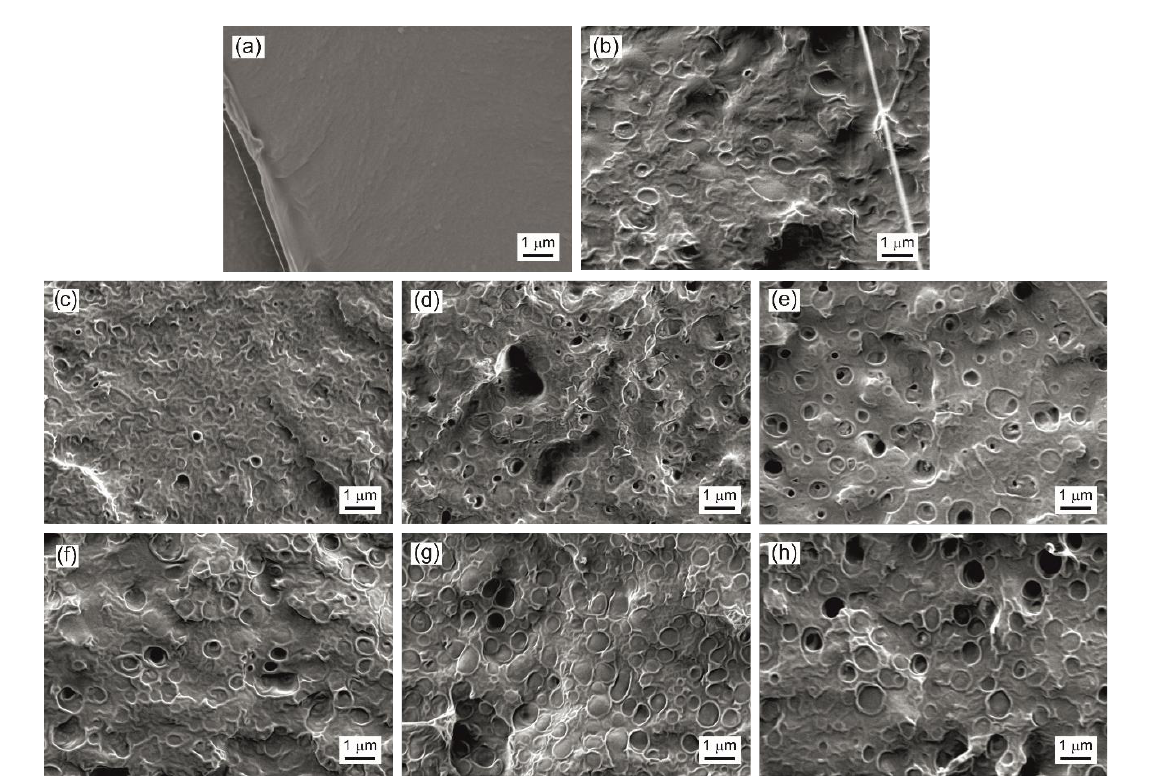
Figure 6. FESEM images at 10,000 × of fracture surface of ( a ) PLA; ( b ) PLA–PHB blend (B); ( c ) B-5ECO; ( d ) B-7.5ECO; ( e ) B-10ECO; ( f ) B-5MCO; ( g ) B-7.5MCO; and ( h ) B-10MCO.